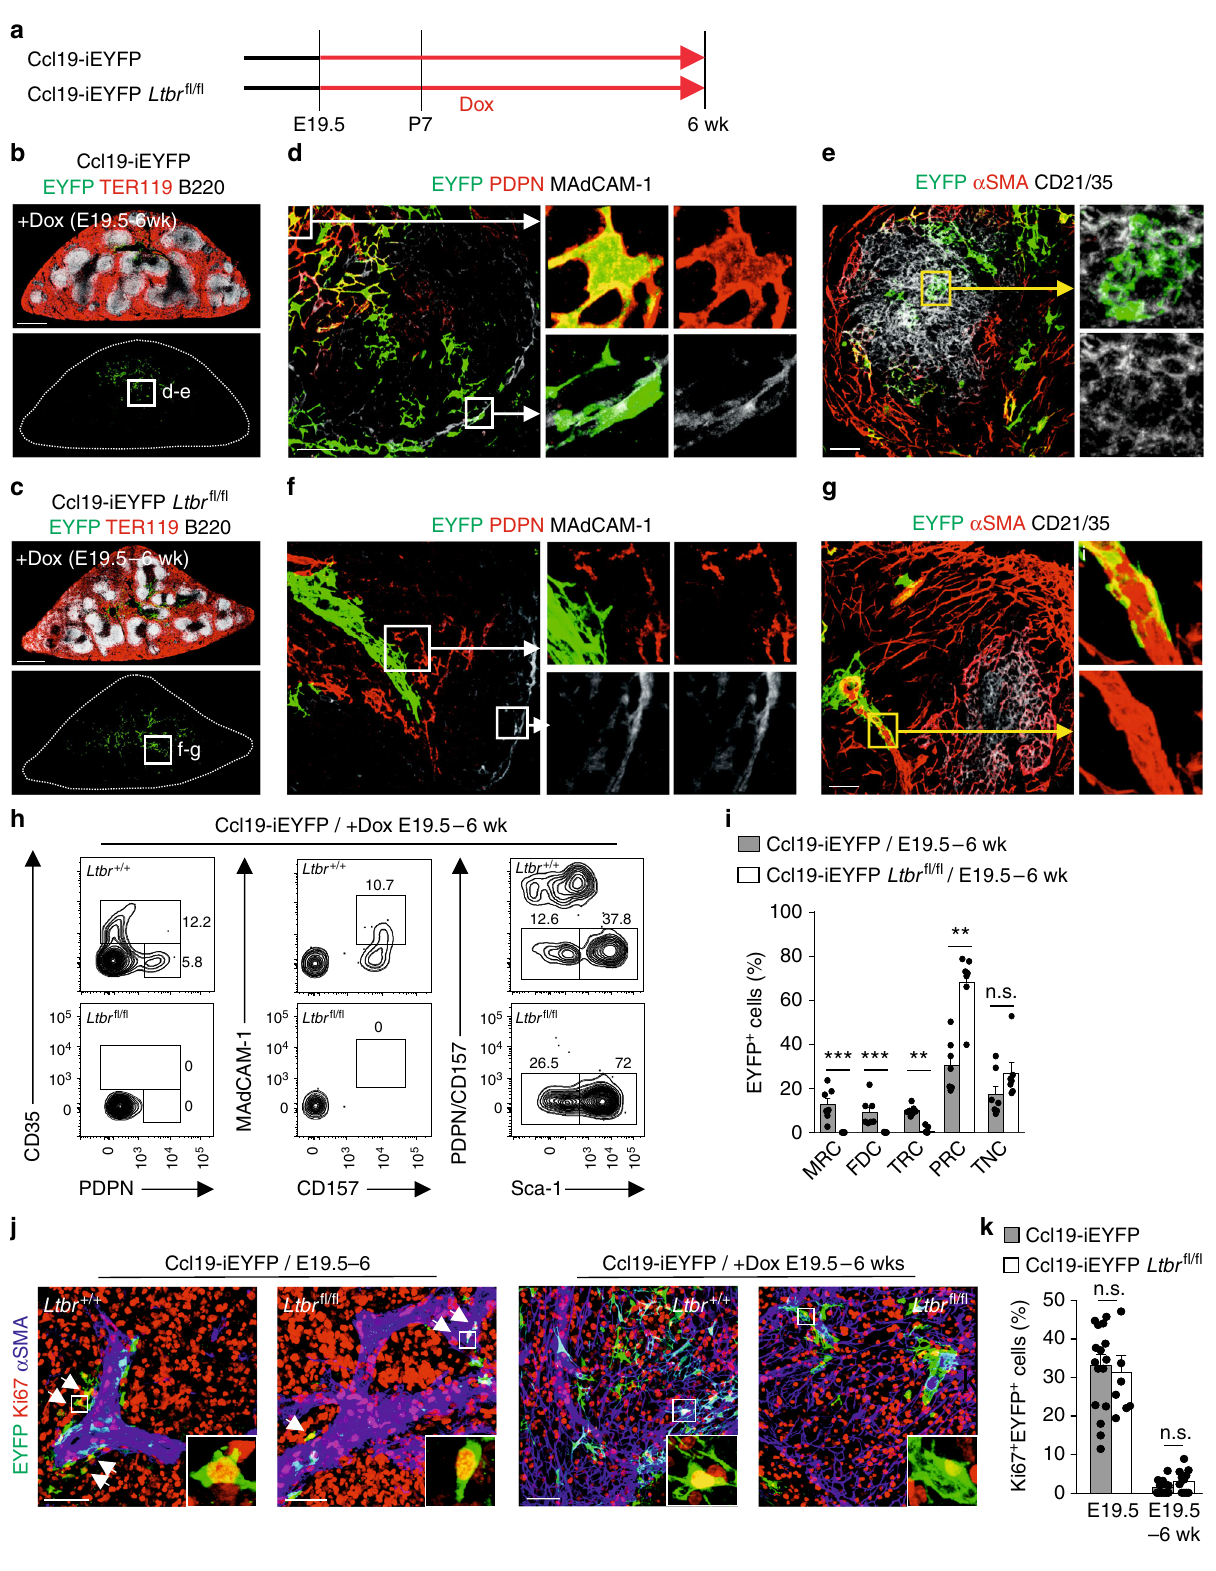
of Sca-1 expression and the lack of CD44 and reduced CD106 expression (Fig. 6e). Confocal microscopy revealed that CD29 + Calponin-1 + TNC1 form a distinct mural cell layer around white pulp arterioles (Fig. 6f). Gene-set enrichment analysis substantiated that this distinct mural cell subset contributes to blood vessel contractility and lacks the